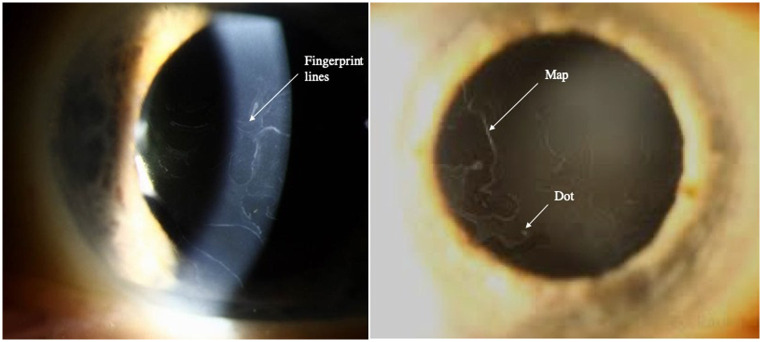
Slit-lamp photography of a cornea with EBMD.Fingerprint lines, geographic map-like lines, and epithelial dot are designated by arrows.